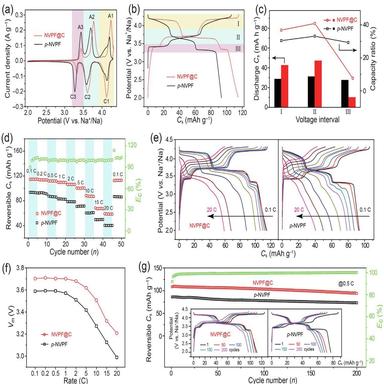
(Color online) The electrochemical properties of NVPF@C and p-NVPF tested in coin-type half cells. (a) CV patterns at a scan rate of 0.1 mV s1 and (b) GCD curves at a current density of 0.1 C (1 C corresponds to a current density of 128 mA g1 ) in the potential windows of 2.0–4.3 V vs. Na+ /Na; (c) the discharge Cs values and capacity ratios of three voltage intervals calculated from the discharge curves in (b); (d, e) rate capability and the corresponding GCD curves from 0.1 to 20 C; (f) Vm variations calc